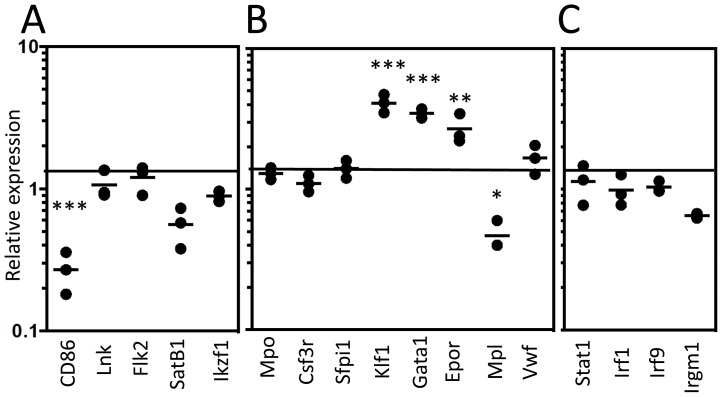
Erythropoiesis associated transcripts are overrepresented in JAK2V167F HSC.Gene expression analysis was performed by Real-Time PCR on a small panel of genes, normalizing with GAPDH for a reference housekeeping gene. Lymphoid genes (A), myeloid-, erythroid-, and megakaryocytic- genes (B), and IFNγ responsive genes (C) were indicated. The data are representative of those obtained in two independent experiments p<0.001(***), p<0.05(*).